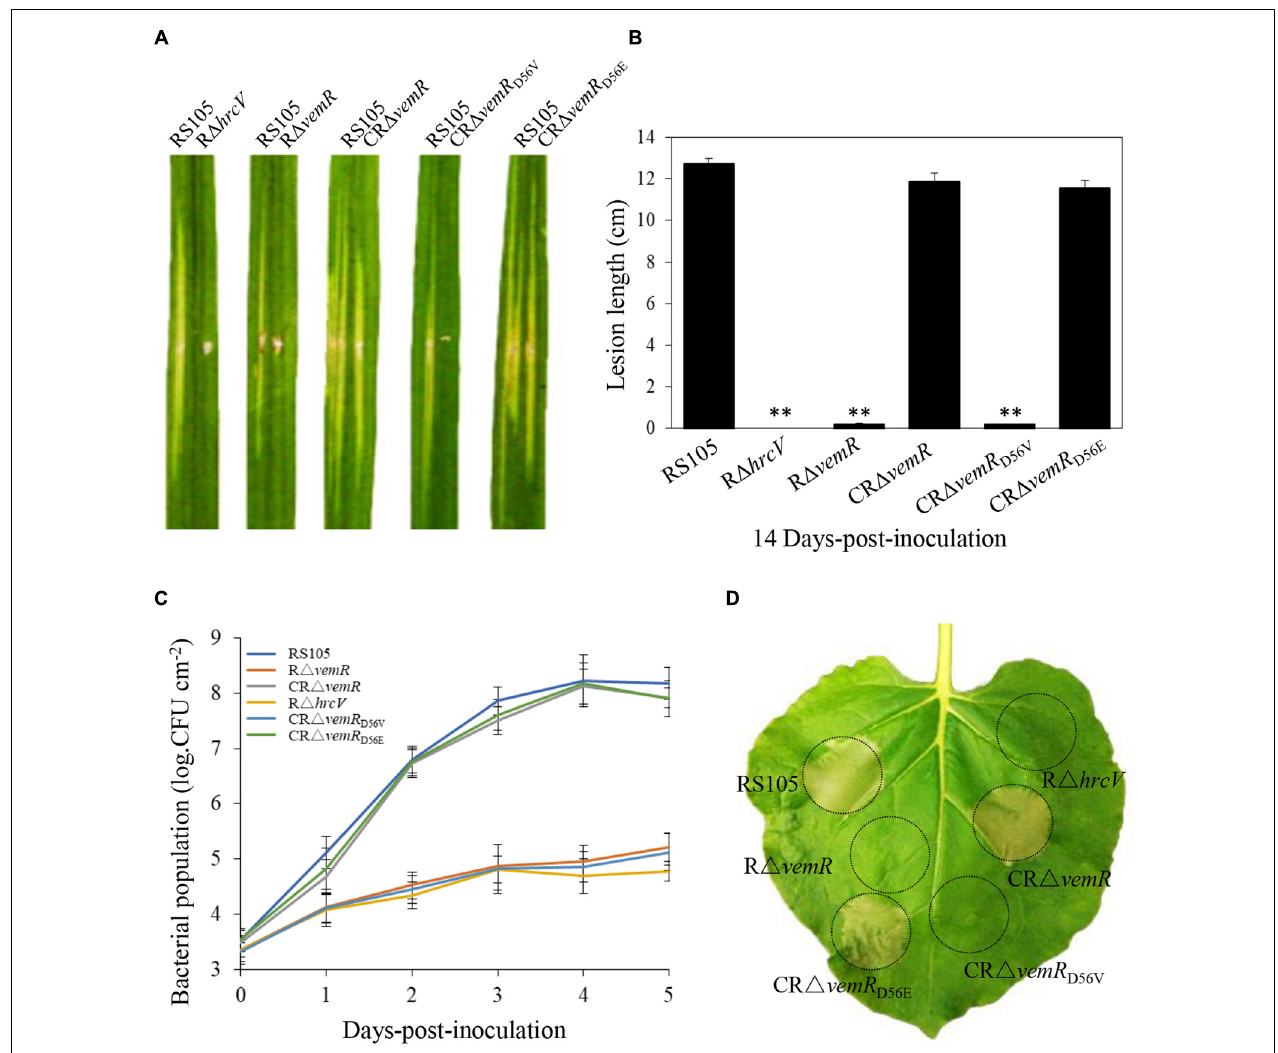
FIGURE 2 | vemR is required for full virulence and growth of X. oryzae pv. oryzicola ( Xoc ) in rice and HR induction in tobacco. (A) Symptoms caused by different Xoc strains (suspended in water to Abs 600 = 0.3, app. 1 × 10 8 CFU ml - 1 ) on leaves of susceptible rice cultivar Shanyou63 by leaf-needling inoculation. (B) Bacterial leaf streak lesions on rice leave caused by Xoc strains. Values are the mean ± standard deviation (SD) from three replicates, each with inoculations on five leaves. Photographs and lesion length data were taken at 14 days-post-inoculation (dpi). Student t -test ( p = 0.01) was used to separate the significantly different means (denoted by **) relative to the wild-type RS105 controls. (C) Growth of Xoc mutant strains in planta . Bacteria were isolated from the inoculated leaf tissue excised at the indicated time points, homogenized in sterile water and the isolated bacteria were plated on selective NA plates. Bacterial colonies were enumerated after incubation at 28 ◦ C for 3 days. The presented data are the mean ± standard deviation (SD) from three independent experiments with five replicates each. (D) HR induction on non-host tobacco ( N. benthamiana ) leaves by Xoc strains (suspended in water to Abs 600 = 0.3, app. 1 × 10 8 CFU ml - 1 ). The experiment was independently repeated three times. The photograph was taken 24 h-post-inoculation (hpi) from a representative leaf. The T3SS-deficient strain R (cid:49) hrcV was used as a negative